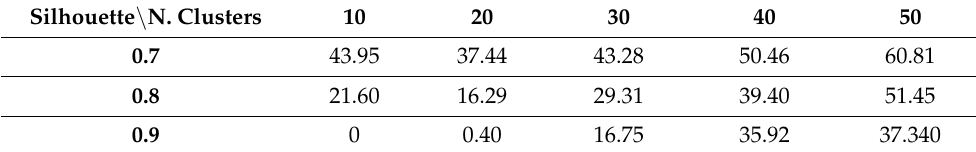
Table 2. Clustering performance in terms of silhouettes using the reduced dataset with PCA. Silhouette \ N. Clusters